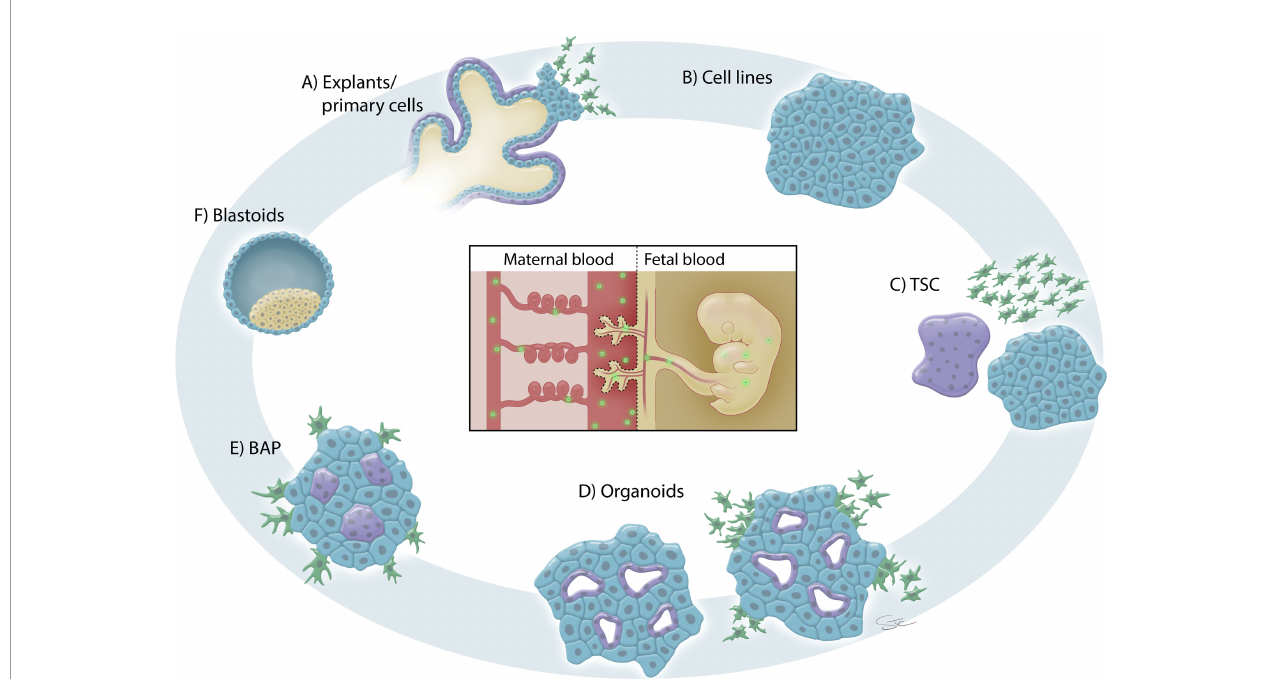
FIGURE 2 | In vitro trophoblast models for placental infection studies. (A) Primary cells and explant cultures from the fi rst, second and third trimesters of human pregnancy have been used to study placental susceptibility to infection. These explant cultures contain all the trophoblast lineages (VCT, blue; SCT, purple; EVT; green) albeit at different proportions depending on the gestational age of the sampled tissues. (B) Various immortalized and cancer-derived trophoblast cell lines have also been used to study placental susceptibility to infection. The cartoon is simpli fi ed to demonstrate that typically only a single cell type is represented in these models. (C) Trophoblast stem cells (TSC) provide a new model for the study of lineage-speci fi c effects of viral infections during pregnancy since all trophoblast lineages can be induced. TSC can be generated from embryonic/induced pluripotent stem cells or isolated from blastocyst outgrowths and fi rst trimester placental tissue. (D) Trophoblast organoids can be generated from fi rst trimester placentas. Organoids more closely mimic the villous structures of the placenta than two dimensional models and can be induced to differentiate into EVT. Trophoblast organoids can be utilized to study vertical transmission of virus as the layers of the placental villi are present in three-dimensions (albeit “ inside-out ” ). (E) Stem cell-derived trophoblast (BAP) have been used to study placental susceptibility to several viral infections. This model most closely represents early placentation and contains a heterogenous population of trophoblast cells. (F) Blastoids, generated from embryonic/induced pluripotent stem cells, provide a new model of early human embryo structures. Blastoids could be used to investigate placental susceptibility to infection during the peri-implantation phase of